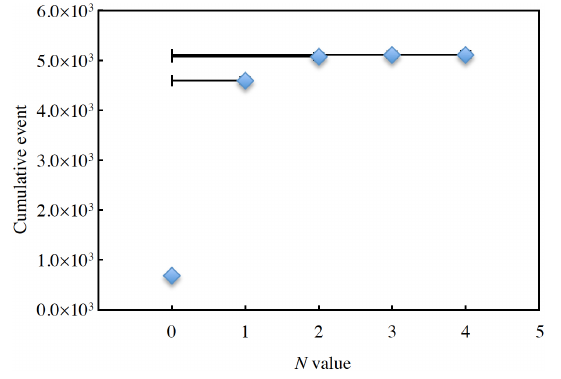
Figure 10. Number of event tracks as a function of N . Error bars indicate the range of integration.